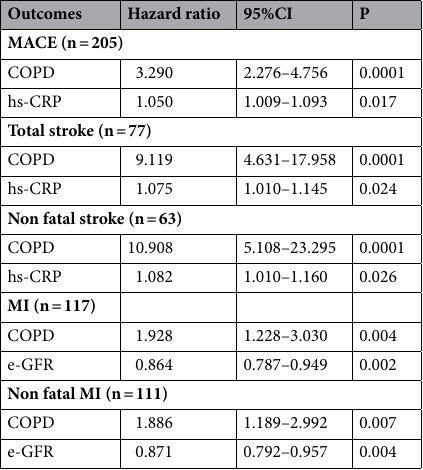
Table 4. Multiple Cox regression analysis for study outcomes. Data are adjusted for: age, gender, body mass index, smoking, systolic blood pressure, fasting plasma glucose, HDL-cholesterol, e-GFR, hs-CRP, and blood pressure target achievement during pharmacological treatment (yes/no). COPD: chronic obstructive pulmonary disease; e-GFR: estimated glomerular filtration rate; hs-CRP: high sensitivity C reactive protein; MI: myocardial